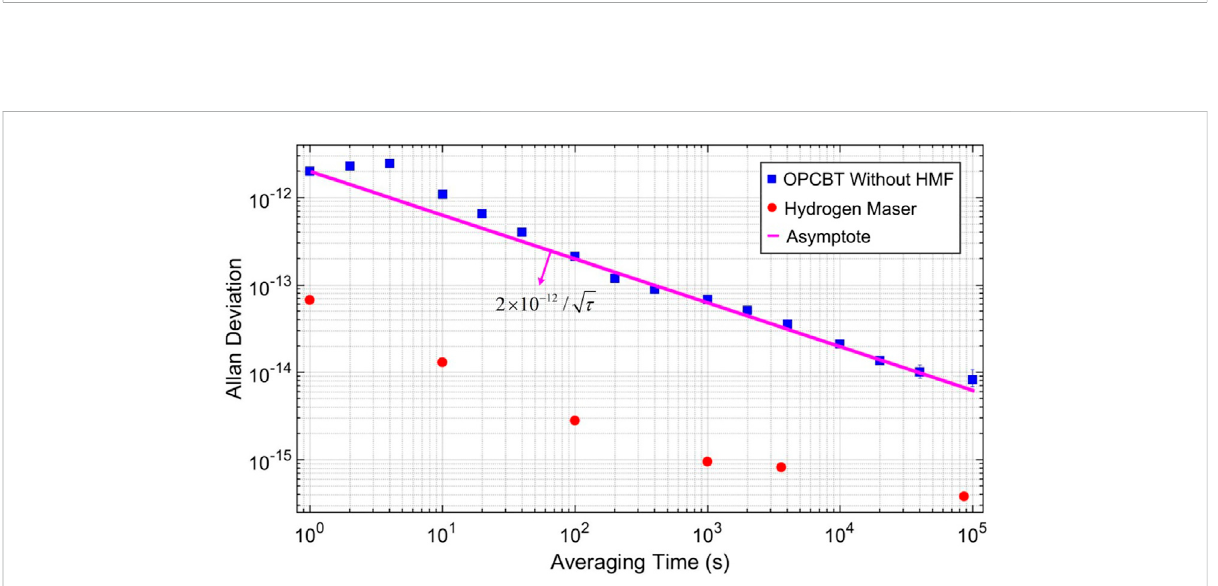
FIGURE 3 Allan deviation of the compact Cs beam clock based on the OPCBT without HMF (blue squares). The purple-solid line is the asymptote fi tted (cid:1) √ τ with 2 × 10 − 12 / . Red circles are the frequency instability of the reference Hydrogen maser.